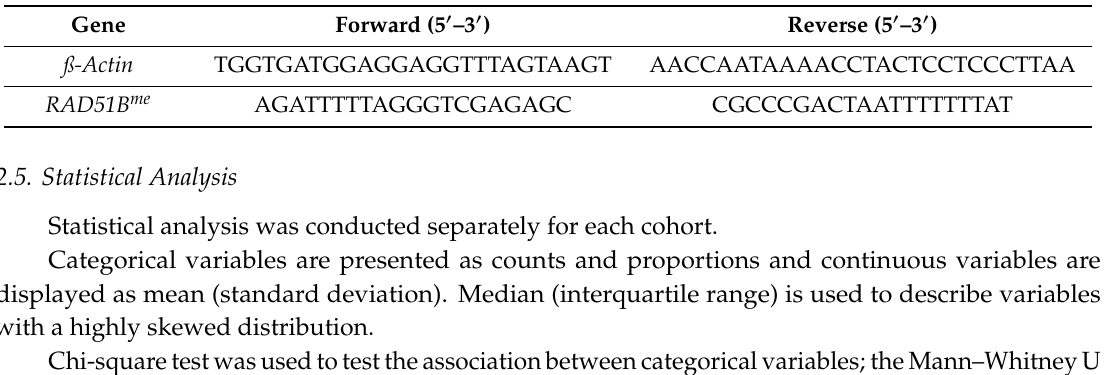
Table 1. Primer sequences for ß-Actin and RAD51B me